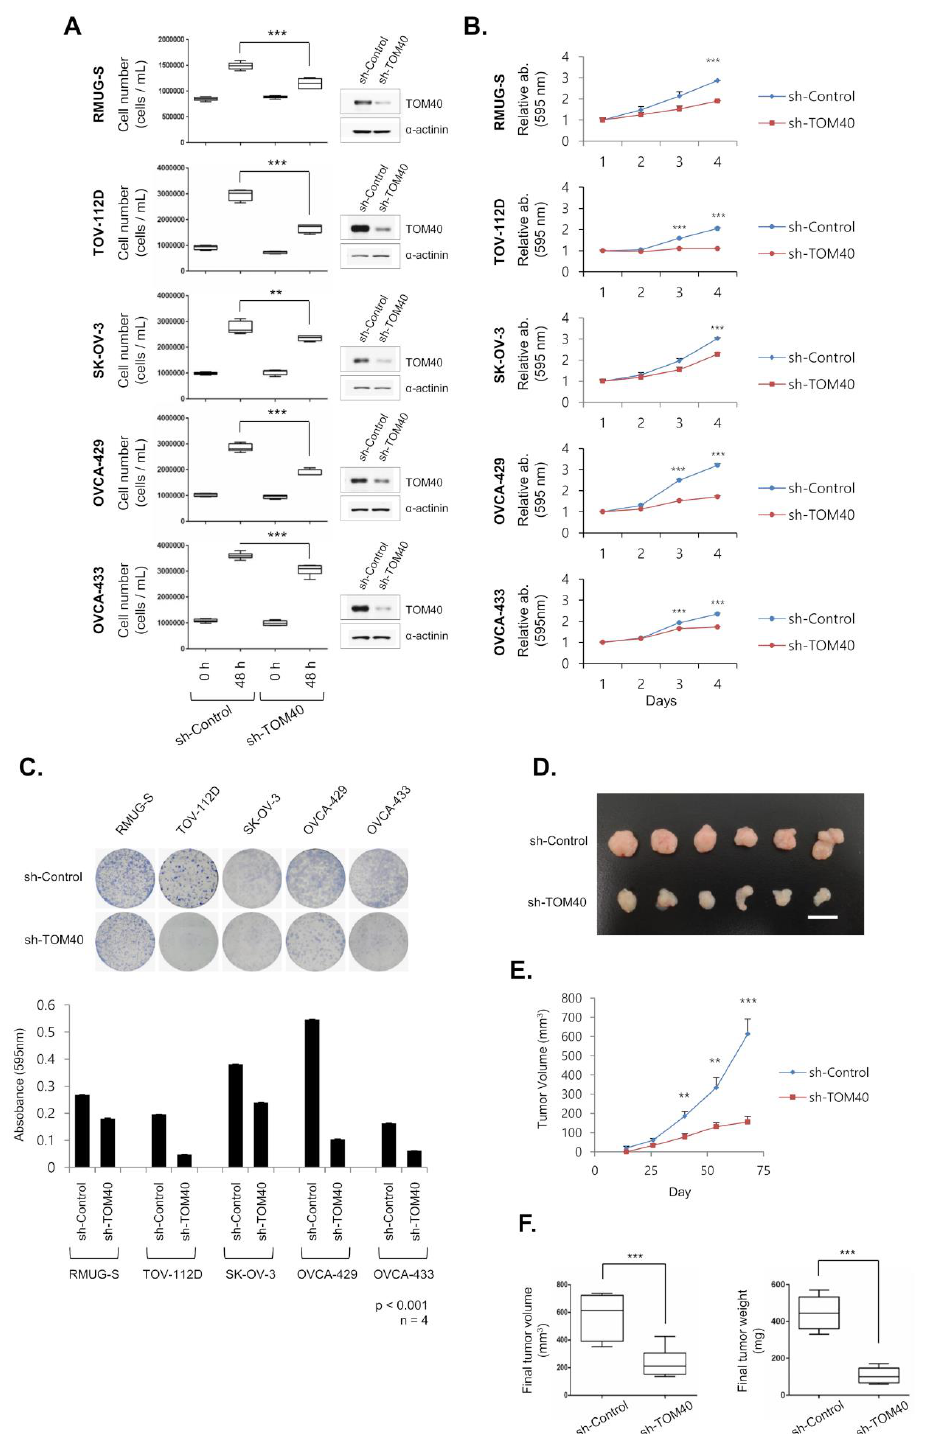
Figure 2. TOM40 promotes the proliferation of epithelial ovarian cancer (EOC) cell lines and EOC xenografts. EOC cell lines (RMUS-S, TOV-112D, SK-OV-3, OVCA-429, and OVCA-433) that stably express sh-control and sh-TOM40 were established by lentivirus and selected with 3 μg/ml puromycin for 15 days. ( A ) Numbers of EOC cells that stably express sh-TOM40 were counted 48 hours after seeding with a LUNAII TM automated cell counter. Data are expressed as the mean ±